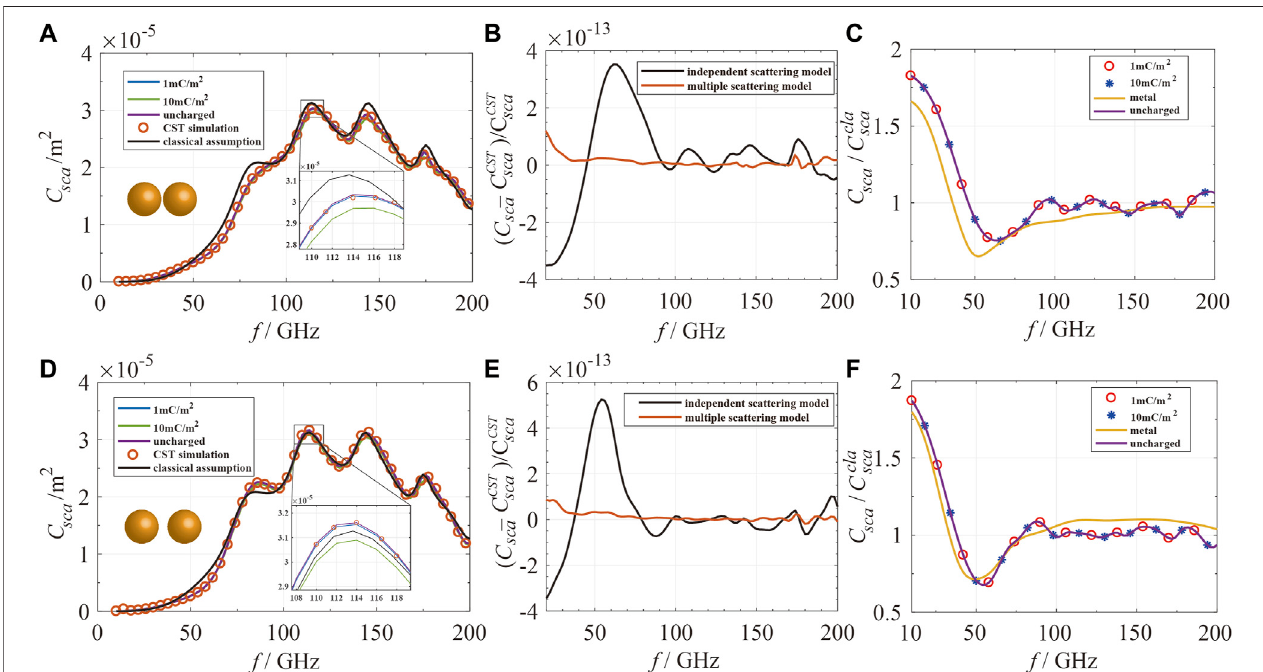
FIGURE 5 | The scattering cross sections for two-particle systems with different separations and charge densities. First column: the scattering cross section of two-particle clusterscalculated under the multiple scattering method(for unchargedparticlescharged particles), classical independent scattering assumption, and CST simulation (for uncharged particles) with the radius of particles equal to 1 mm; distances between two particles are (A) 2.2 mm and (D) 3 mm. Second column: the relative differences between the results calculated under classical assumption, multiple scattering model, and CST simulation for uncharged particles for distance equal to (B) 2.2 mm and (E) 3 mm. Third column: the ratio of scattering cross section calculated under the multiple scattering method to the results calculated with the classical assumption for distance equal to (C) 2.2 mm and (F) 3